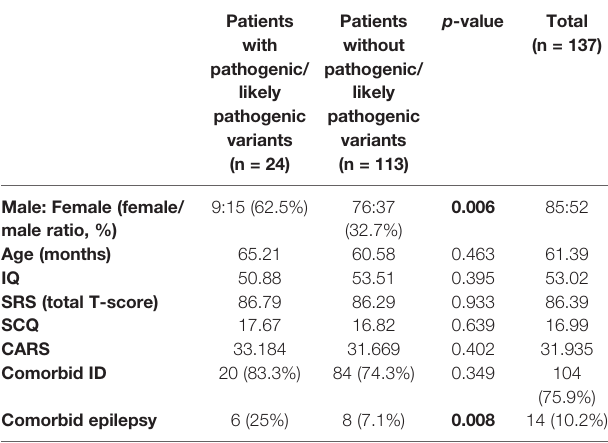
TABLE 1 | Demographic data of